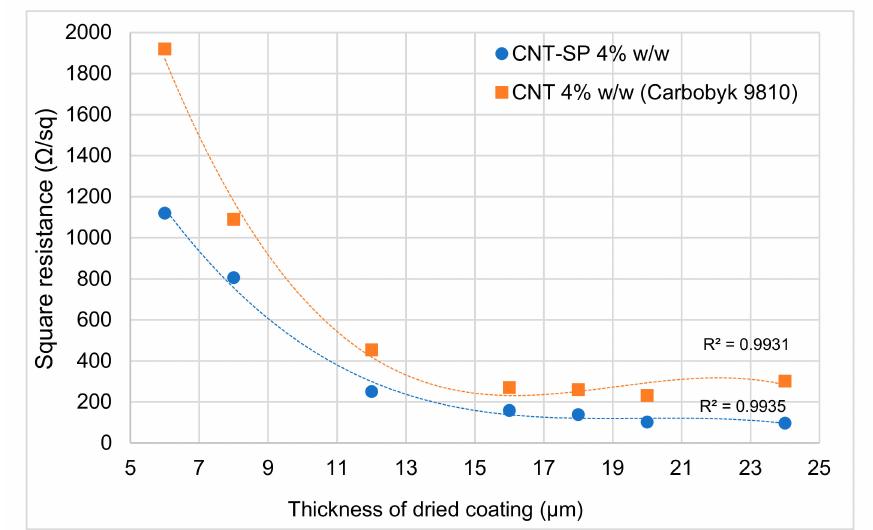
Figure 9. Square resistance vs. thickness of dried coating layers for the following dispersions: based on CNT-SP (blue circles), based on commercially available (Carbobyk 9810) (red squares). Points are interpolated with third grade